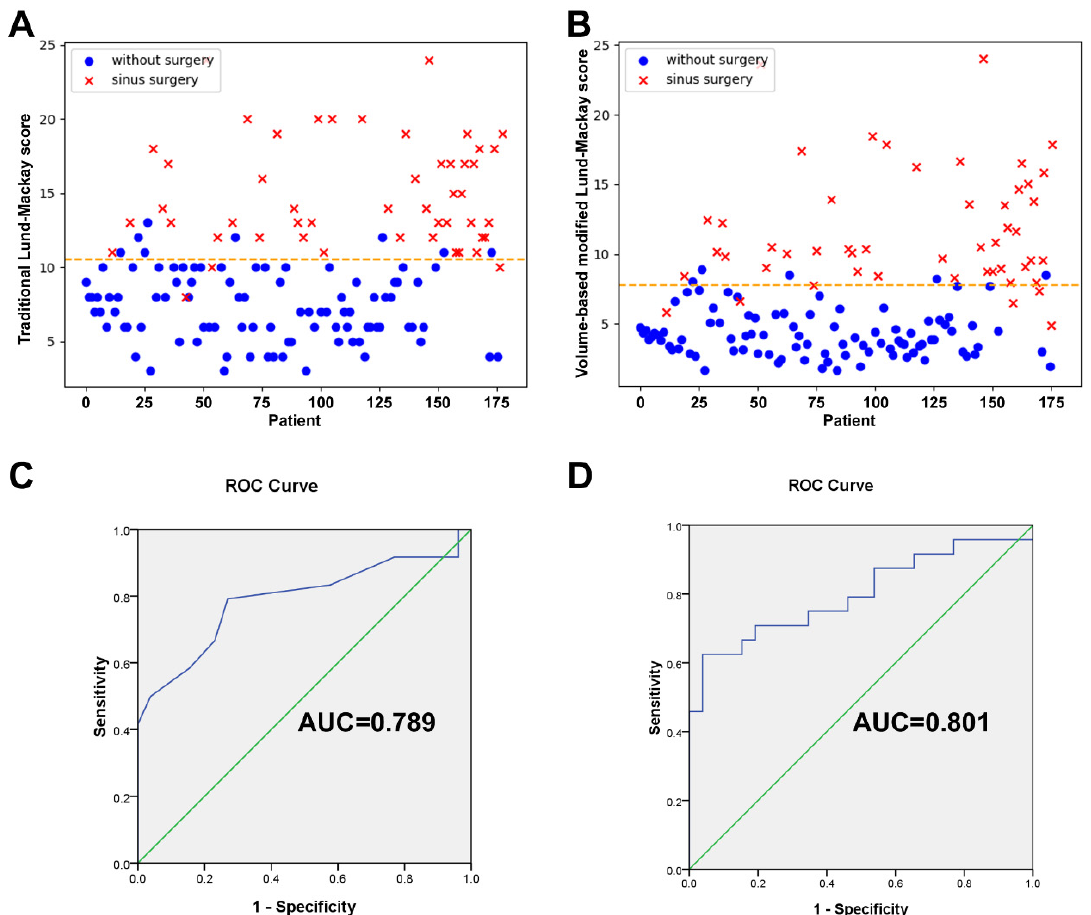
Figure 5. Scatter plots of ( A ) TLMs and ( B ) VMLMs values, grouped by whether. surgery was per- formed or not. ROC with AUC analysis for assessing the correlation between SNOT-22 improvement and the ( C ) TLMs and ( D ) VMLMs scoring system.